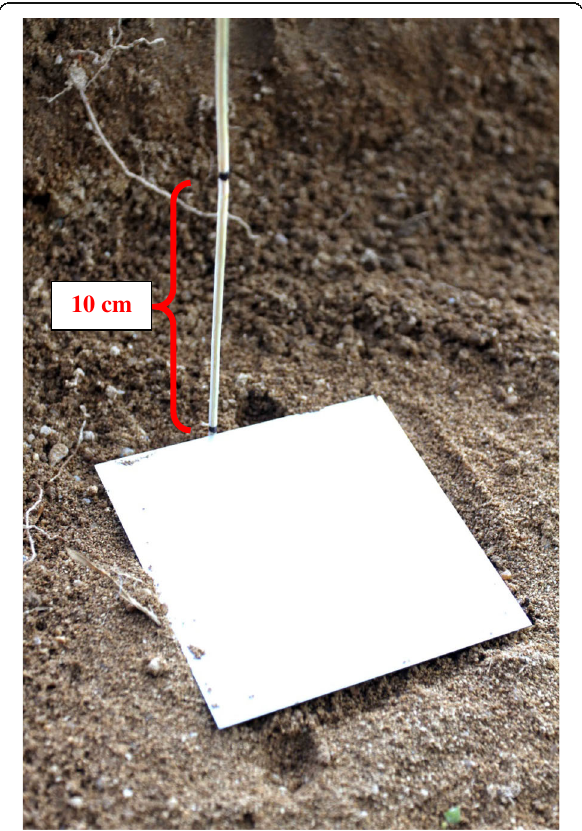
Fig. 3 The stick used as location and depth